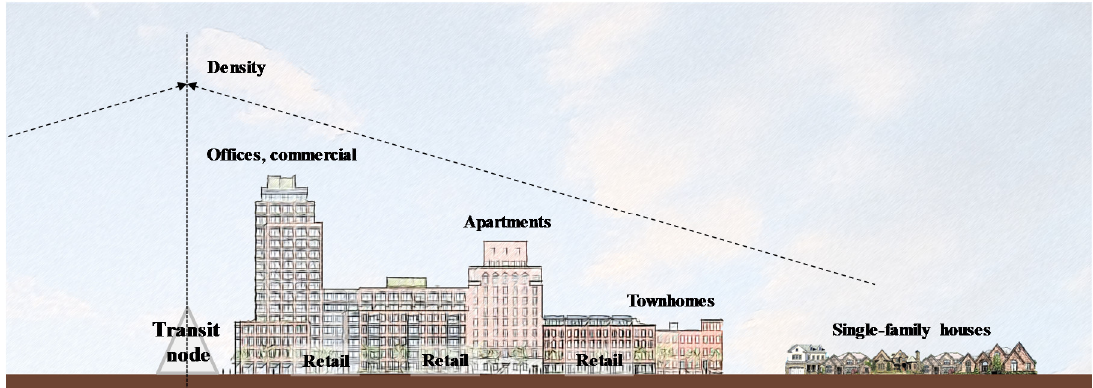
Figure 14. Land use in relation to density and transit nodes [2].